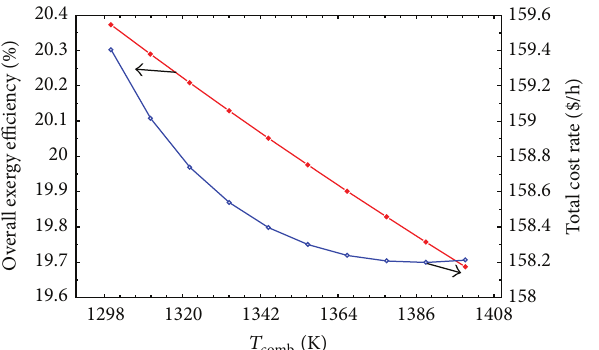
Figure 8: The impact of the compressor pressure ratio on the maximum pressure of ORC.